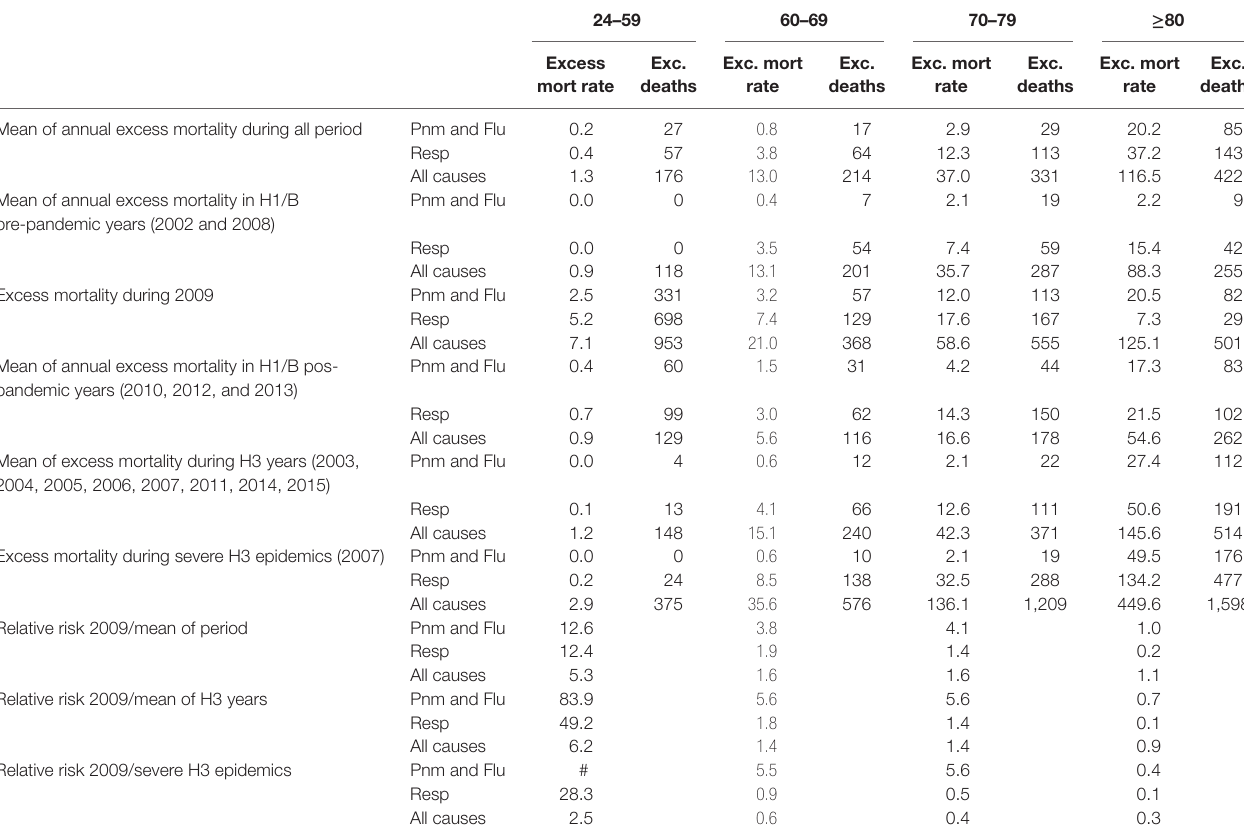
TaBle 2 | Excess mortality rate (per 100,000 population) and excess deaths (absolute number) according to influenza virus subtypes prevalent in southern Brazil,